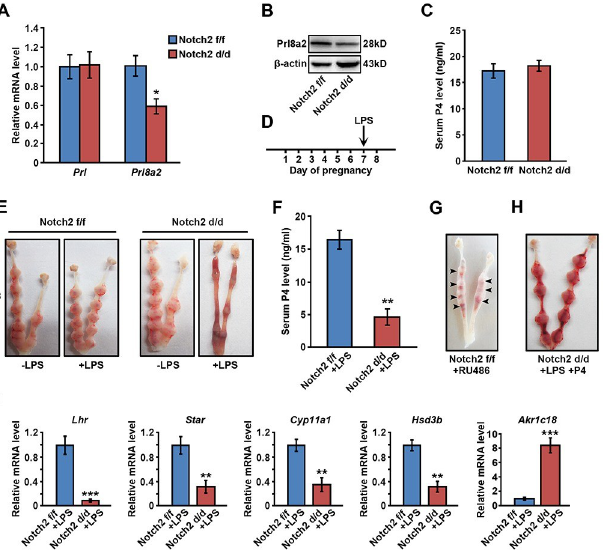
Fig 3. Notch2 d/d females were less tolerant to LPS-induced Prl resistance. (A) The relative mRNA level of Prl and Prl8a2 in Notch2 f/f and Notch2 d/d decidua was examined by QRT-PCR. (B) Western blot analysis revealed the protein level of Prl8a2 in Notch2 f/f and Notch2 d/d decidua. (C) Notch2 f/f and Notch2 d/d females exhibited similar serum P4 level. (D) The scheme shows the LPS treatment schedule. (E) Notch2 d/d mice treated with low-dose LPS experienced pregnancy loss on day 8. (F) The serum P4 level was measured in LPS-treated Notch2 f/f and Notch2 d/d females. (G) RU486 injection resulted in abortion in Notch2 f/f mice. (H) Pregnancy failure in LPS-treated Notch2 d/d females was rescued by exogenous P4 supplementation. (I) The relative mRNA level of genes related to P4 synthesis or degradation was detected by QRT-PCR in ovaries of LPS-treated Notch2 f/f and Notch2 d/d females. Data in (A), (C), (F) and (I) represents mean ± SEM. � p < 0.5, �� p < 0.01, ��� p <